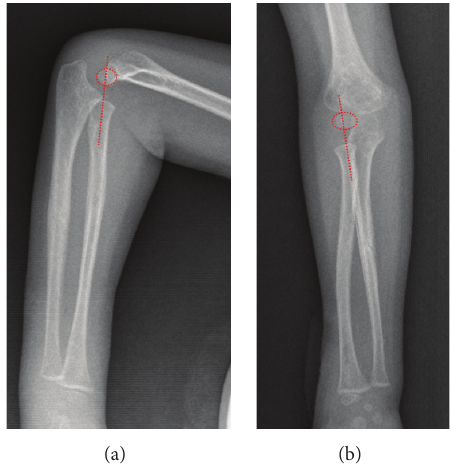
Figure 5: Radiographs after K-wire removal show successful union and reduction at the 6th week.